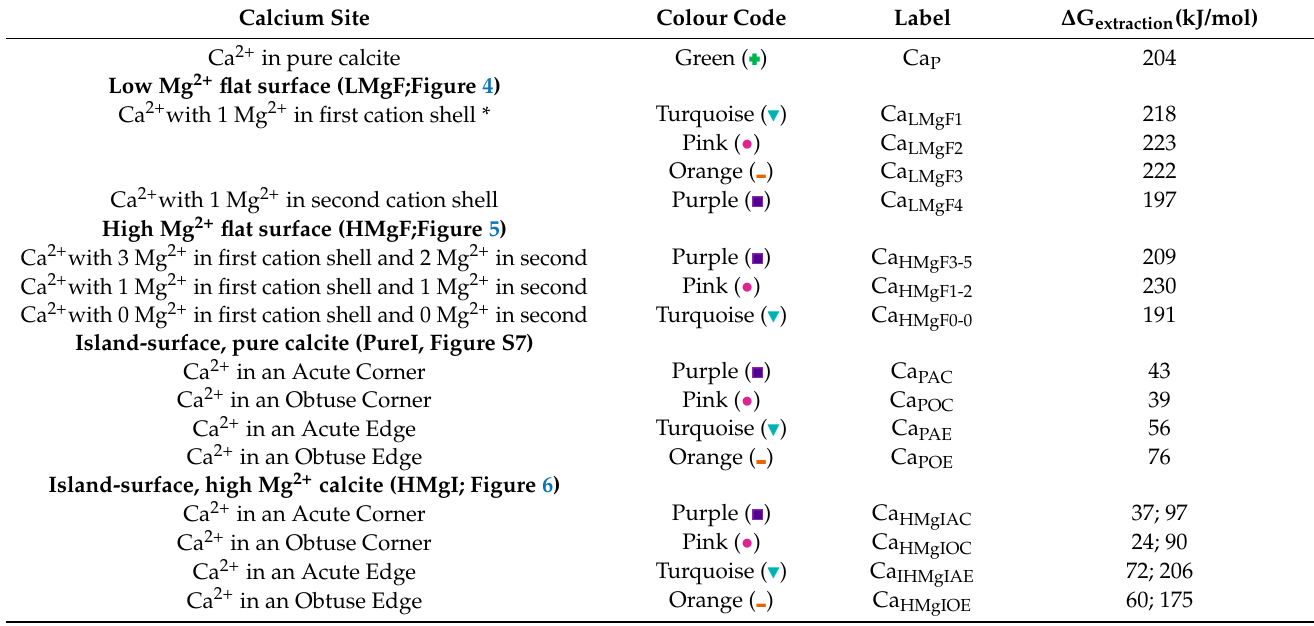
Table 3. Selected calcium sites for forced molecular dynamics (MD) extraction, including the allocated colour code used in Figures 4–6, label and free energy of full extraction. The second free energies reported for the HMgI system are for simulations in which the island CO 32 − molecules were